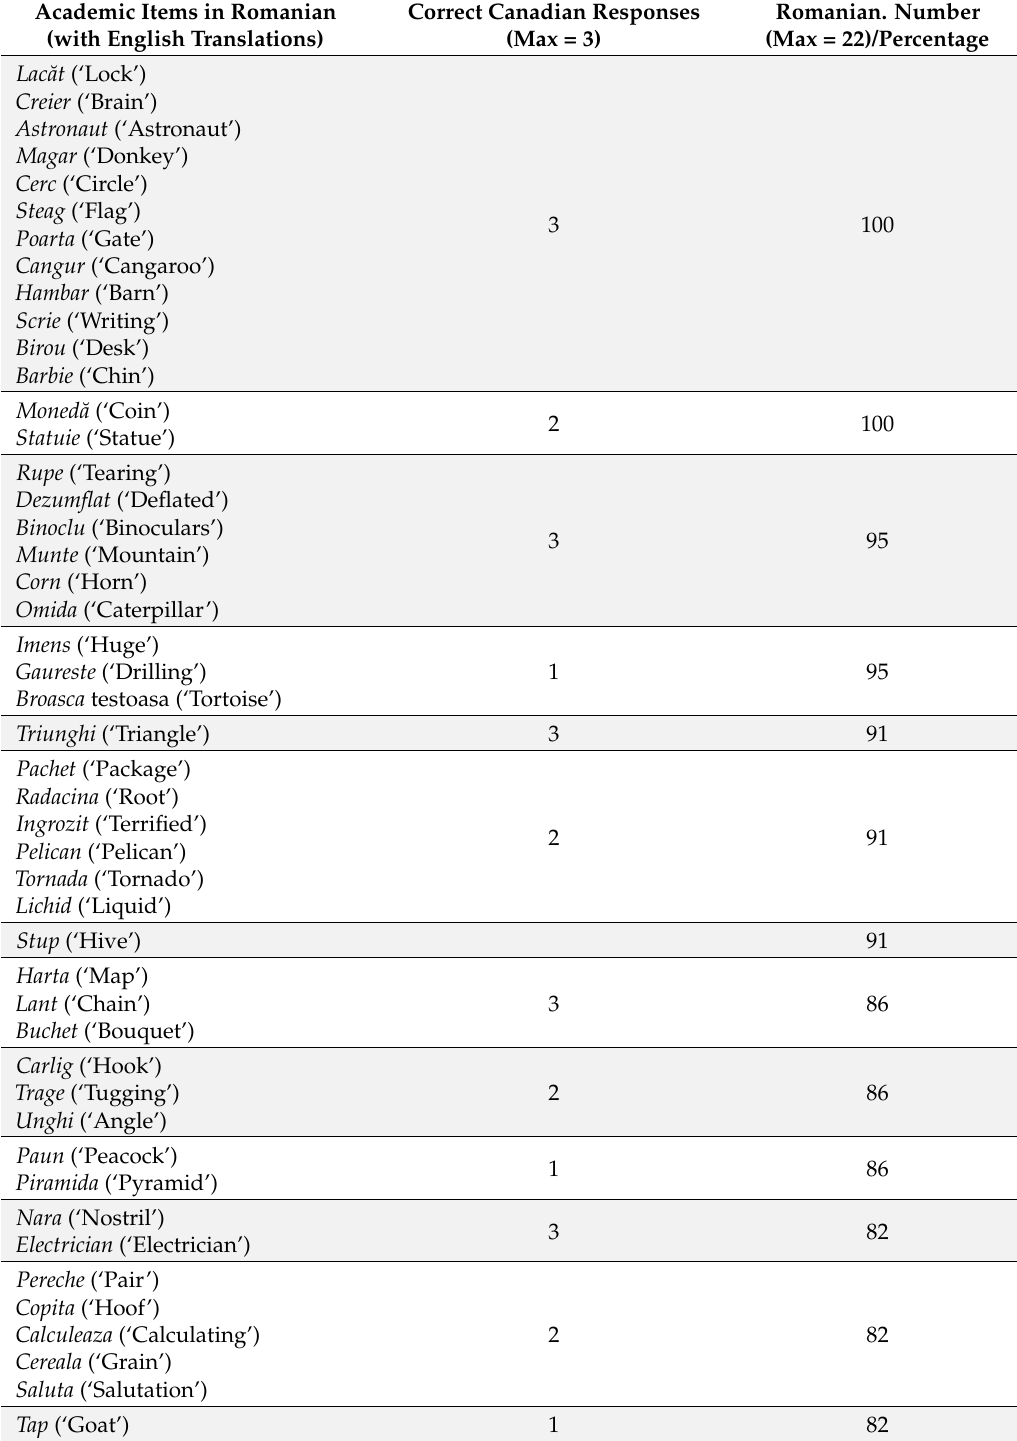
Table A1. Academic Items from PPVT-4